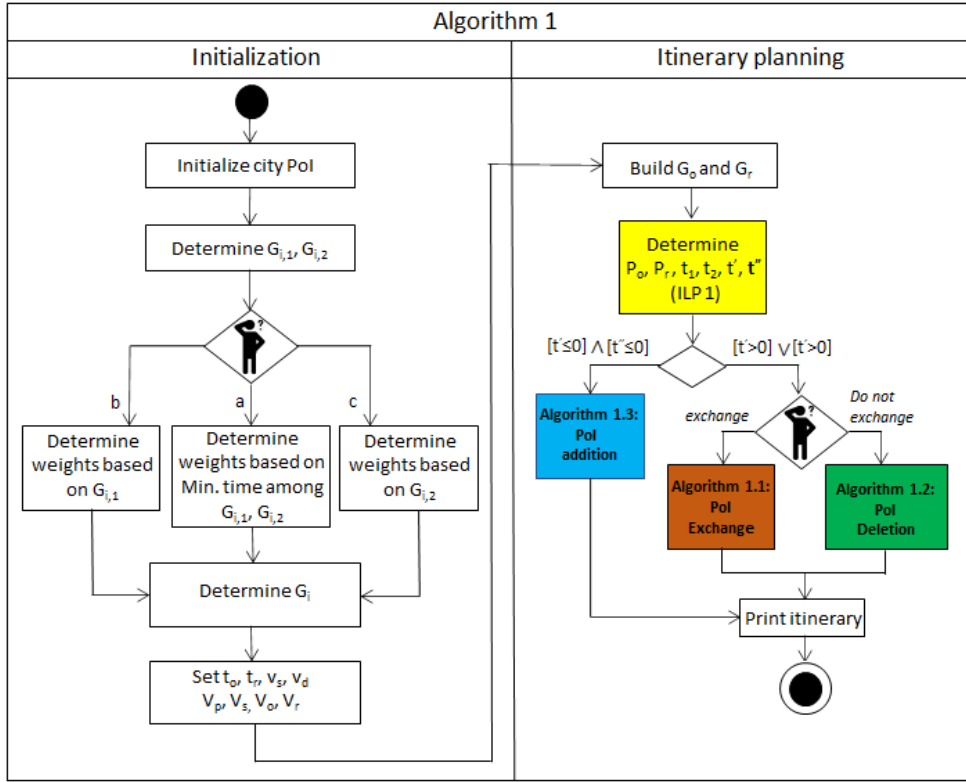
Figure 2. The UML diagram of Algorithm 1: data initialization and itinerary